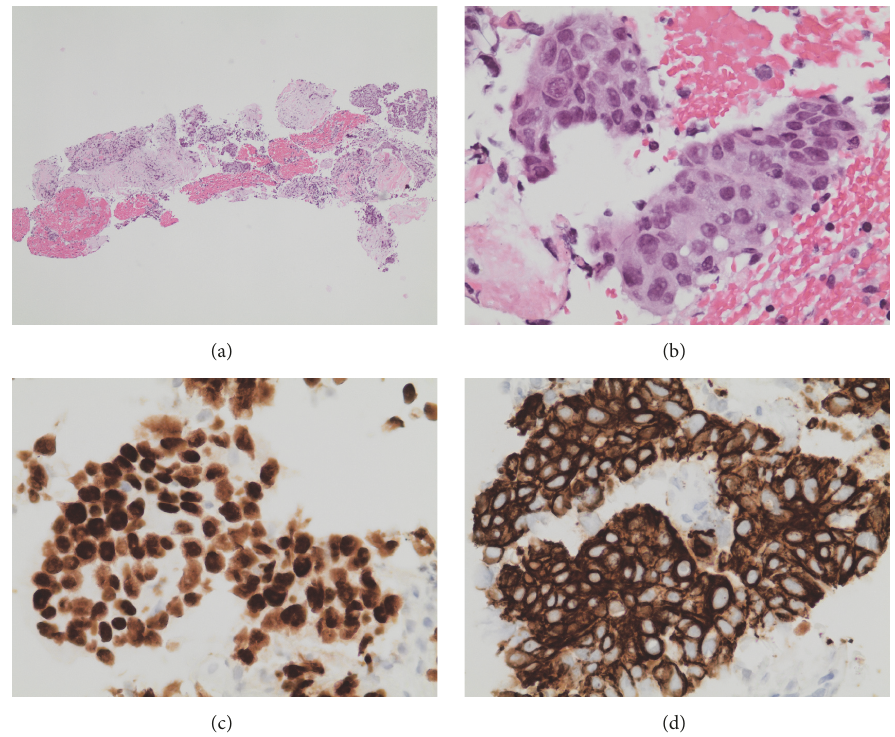
Figure 3: (a) Hematoxylin and eosin staining of a specimen obtained from lung mass with EUS-guided fine needle biopsy. (b) Small core biopsy fragments show invasive carcinoma with clusters and cords of cells that show squamous morphology. (c and d) Immunostains showed that the neoplastic cells express p63 (c) and CK 5/6